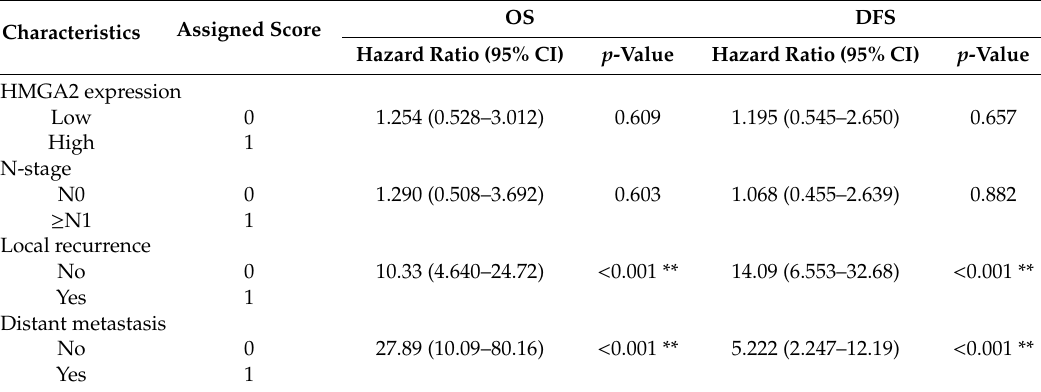
Table 2. Results of the multivariate analysis of prognostic factors by the Cox proportional hazards regression model comparing oral squamous cell carcinoma patients based on HMGA2 expression.